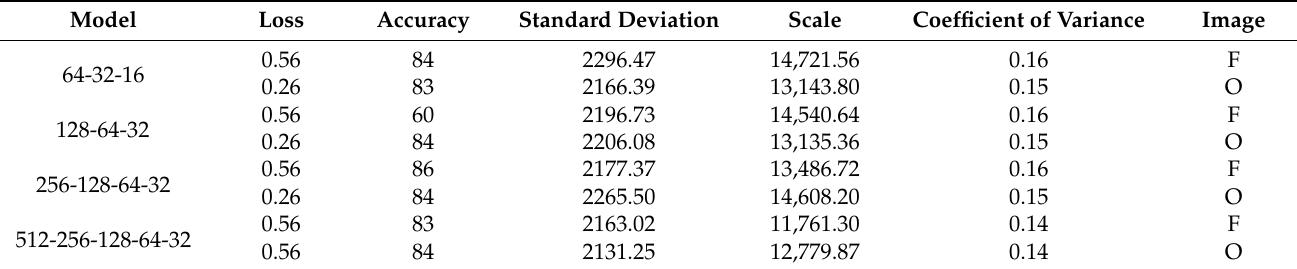
Table 5. CNN model performance against the standardized difference images.